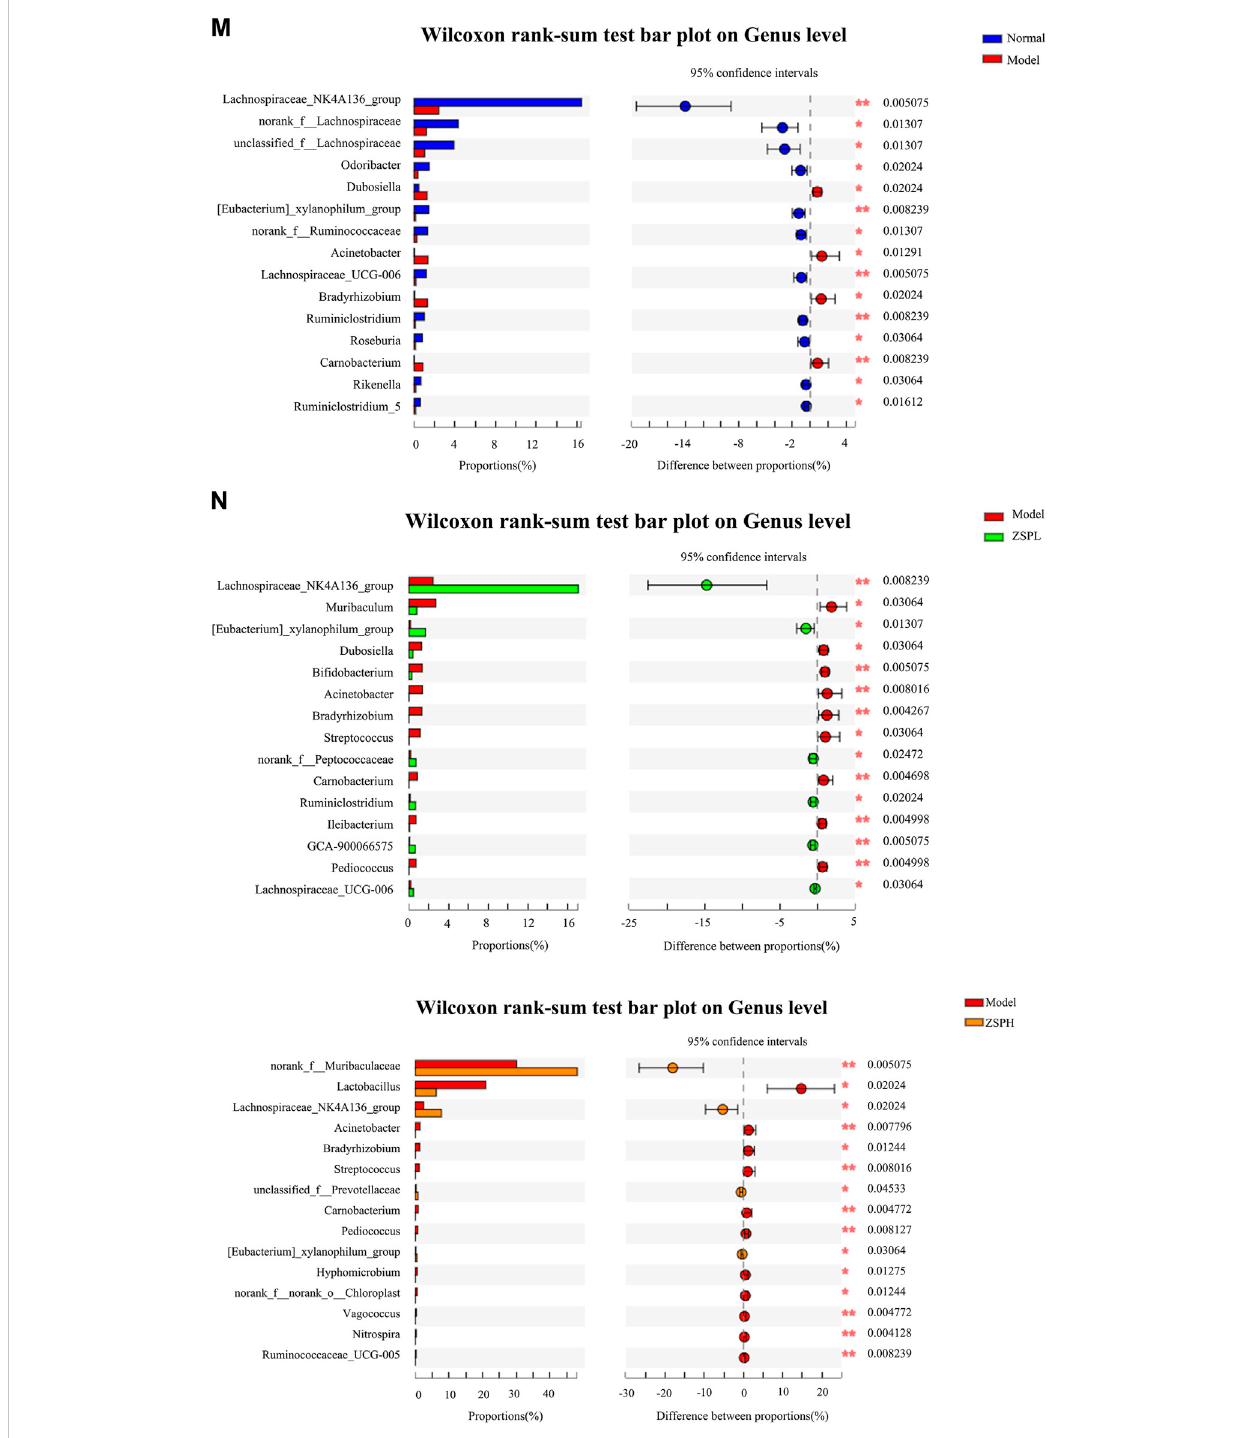
FIGURE 4 (Continued). Prevention and treatment of lung cancer based on the urethane-induced lung cancer model (A) Body weight of urethane-induced lung cancer mice (g). ( n = 6) (B) The whole lung by the naked eye (C) Hematoxylin and eosin ,(H&E) staining of lung tissue (×200). In fl ammatory cell in fi ltration (black arrow); Massive bleeding (blue arrow) and Necrosis score of H&E stained sections ( n = 3) (D) H&E staining of colon tissue (×200). In fl ammatory cell in fi ltration (black arrow); Perivascular edema with lymphocyte in fi ltration (green arrow) and Necrosis score of H&E stained sections ( n = 3) (E) Periodic acid – Schiff stainingof colon (×200) ( n = 3) (F) Alpha-diversity index among the four groups (G) Rarefaction curves based on theoperational taxonomicunit (H) Community column diagram on the phylum level (I) Community column diagram on the genus level (J) Community heatmap on the genus level